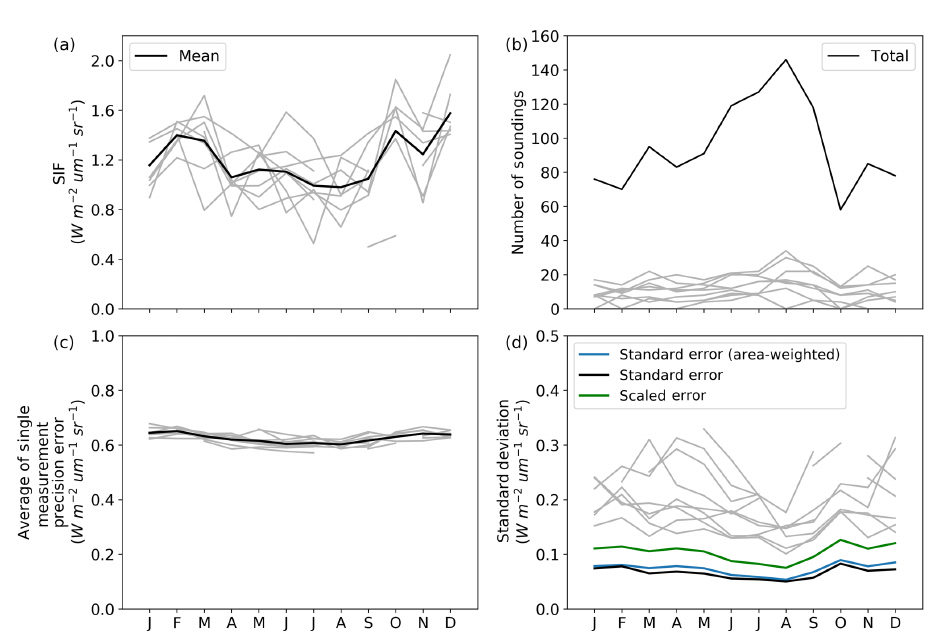
Figure A1. An example of the GOSAT SIF data and uncertainty calculations over a low-resolution model grid cell centred over the Amazon forest at 3.75 ◦ S and 65 ◦ W. Grey lines show individual 3 ◦ × 3 ◦ GOSAT grid cells. Black lines show the aggregated data for the 7.5 ◦ × 10 ◦ model grid cell. Panel (d) shows the calculated uncertainty (standard deviation) at the model grid resolution in black, blue, and green. The black line is the standard error calculated using Eq. (5); the blue line is the standard error calculated using Eq. (A1); the green line is the √ same as the blue but scaled by 2 to account for correlated errors which are used in this